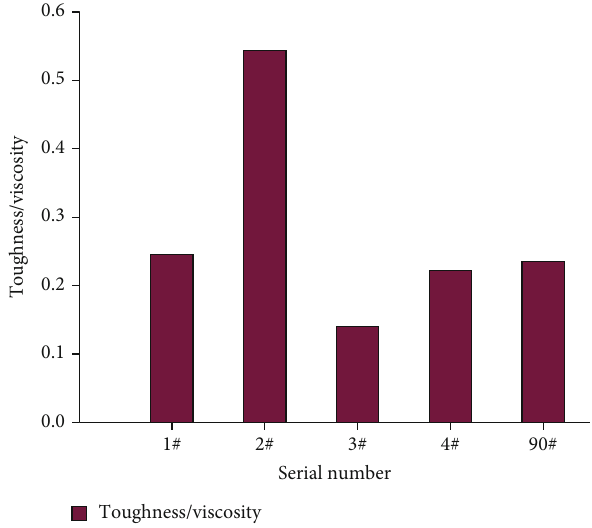
Figure 2: Toughness/viscosity histogram of tire rubber powder- modi fi ed asphalt.